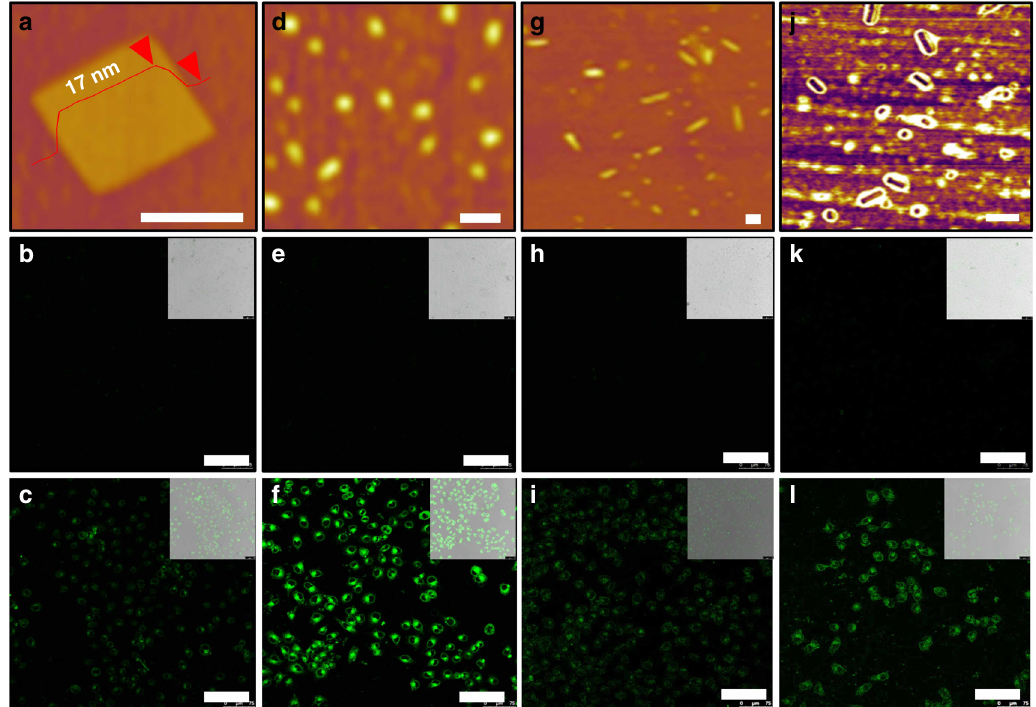
Fig. 5 Cell imaging results. AFM height/phase images of nanoscale Per NS ( a ), Per/OFN NP ( d ), Cor NR ( g ), and Cor/OFN NR ( j ). Confocal images of MCF-7 cells and labeled by Per NS ( c ), Per/OFN NP ( f ), Cor NR ( i ), and Cor/OFN NR ( l ), as well as the corresponding controls unlabeled by any samples ( b , e , h , k ). All the insets are the results under bright fi eld. λ ex = 405 nm. Scale bars in a , d , g , j are 200 nm. Scale bars in b , c , e , f , h , i , k , l are 75 μ